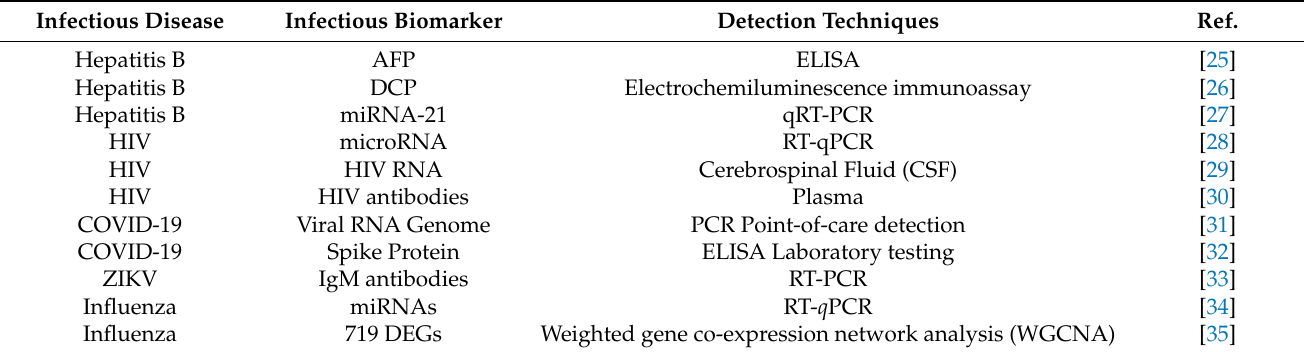
Table 1. Plasma-engineered polymer-based biomarker developed to detect biomarkers of viral